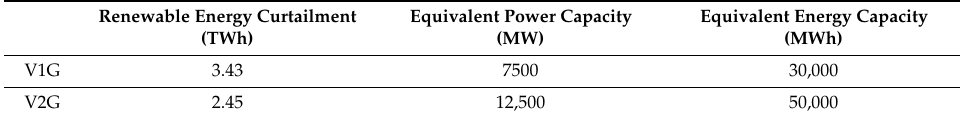
Table 17. Estimated 2030 Levels of Grid Curtailment and Power / Energy Capacity from V1G / V2G. Renewable Energy Curtailment